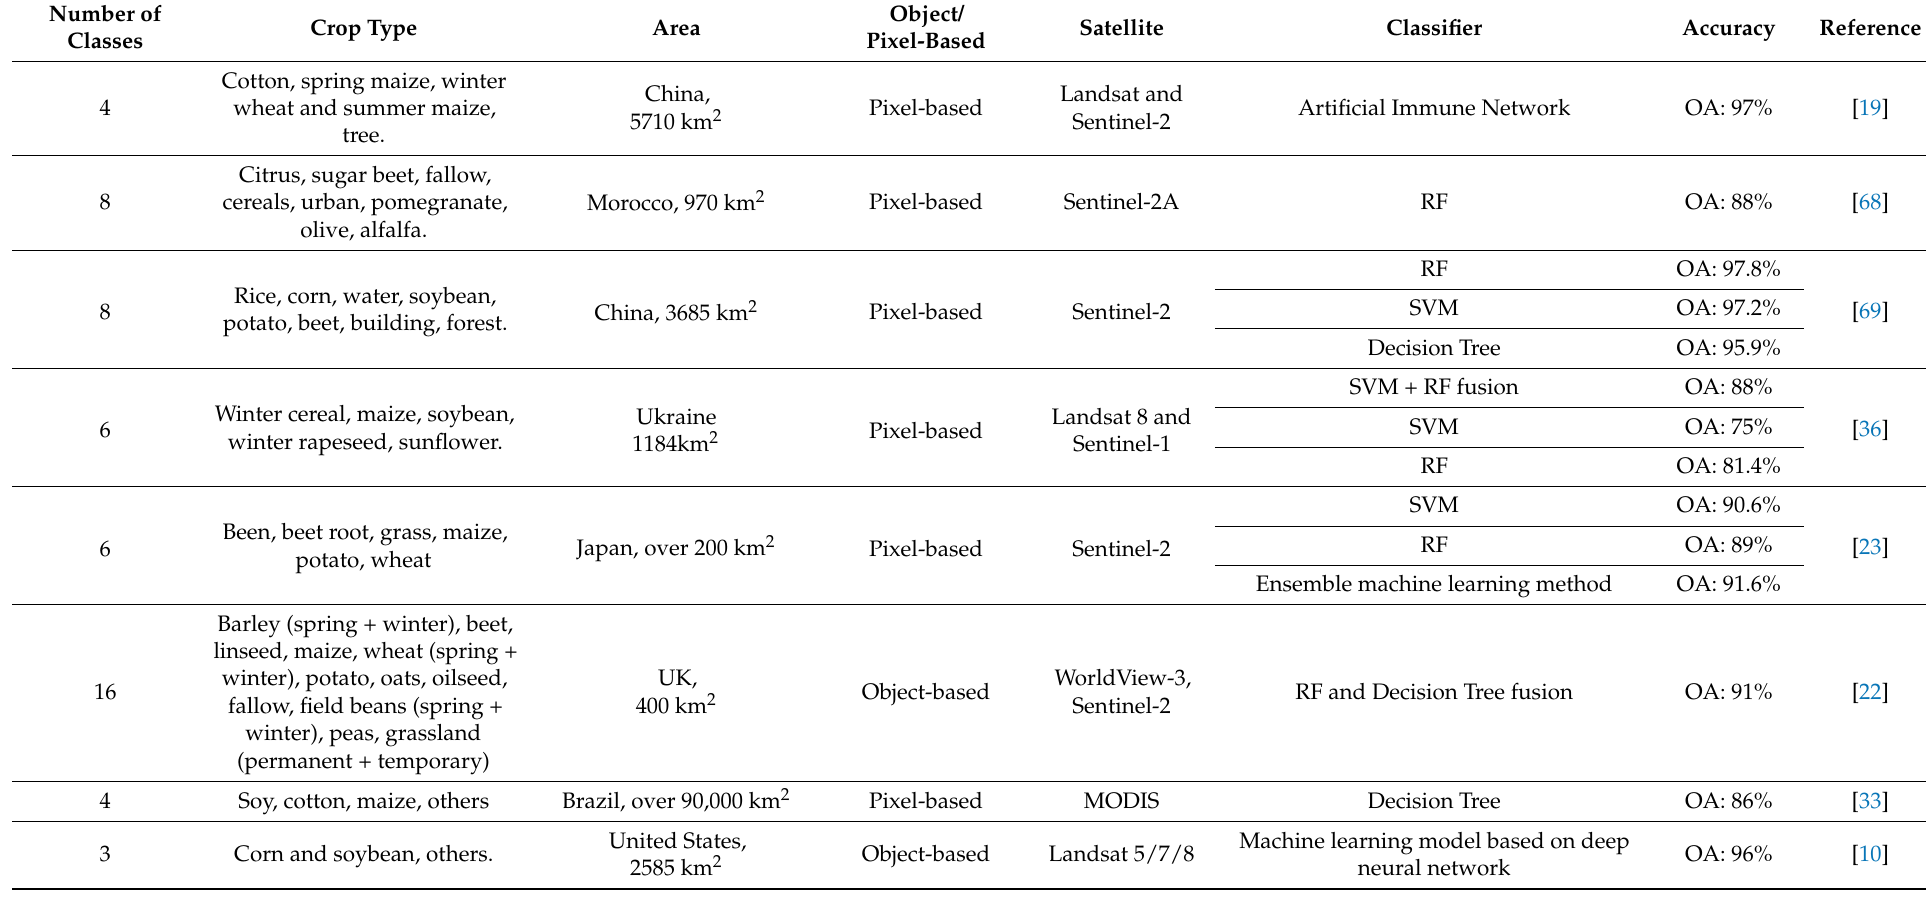
Table 5. A number of OA results of crop classification from studies from the last